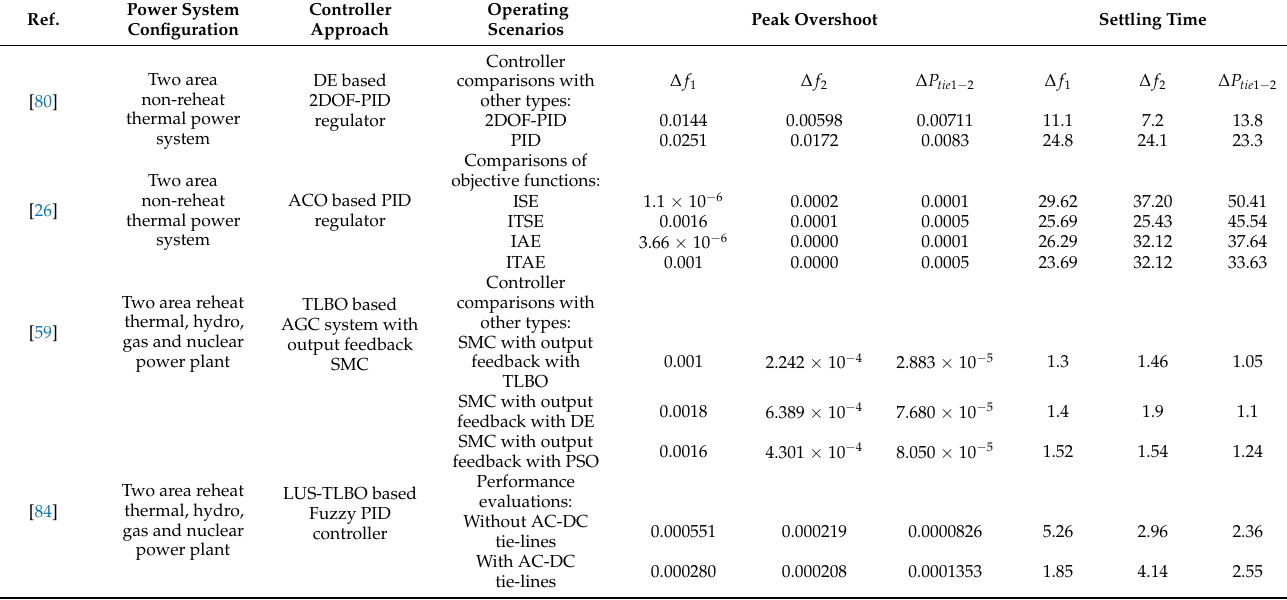
Table 3. Performance evaluation of AGC in two-area power systems with conventional sources. Ref.